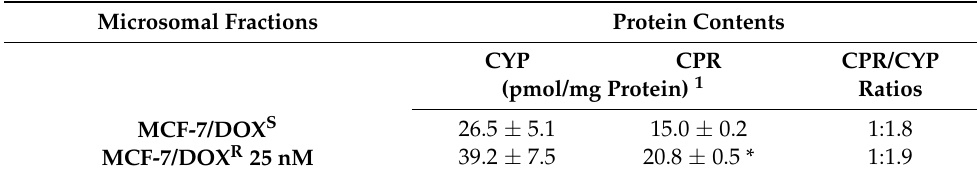
Table 1. Cytochromes P450 (CYP) and cytochrome P450 oxidoreductase (CPR) contents of MCF-7-derived microsomes.